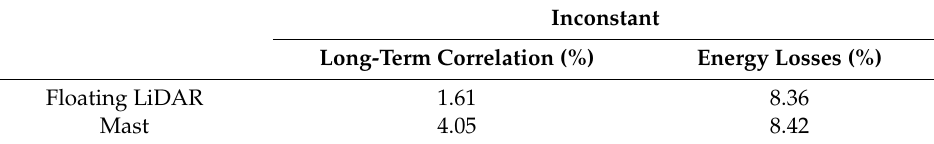
Table 12. Inconstant uncertainty of AEP